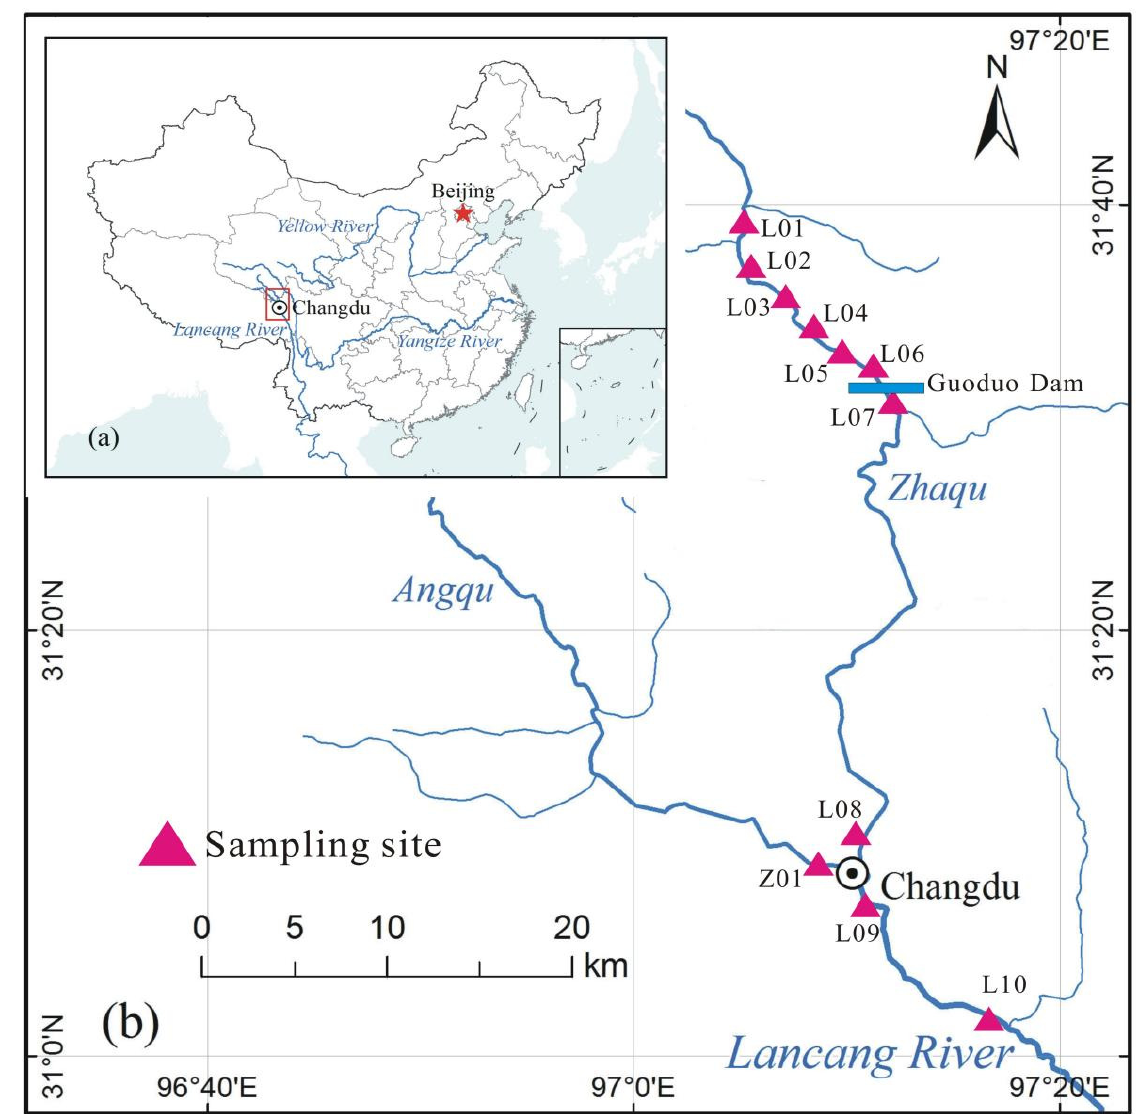
Figure 1. Sampling sites in the study area (( a ): Map of China; ( b ): The study area.).